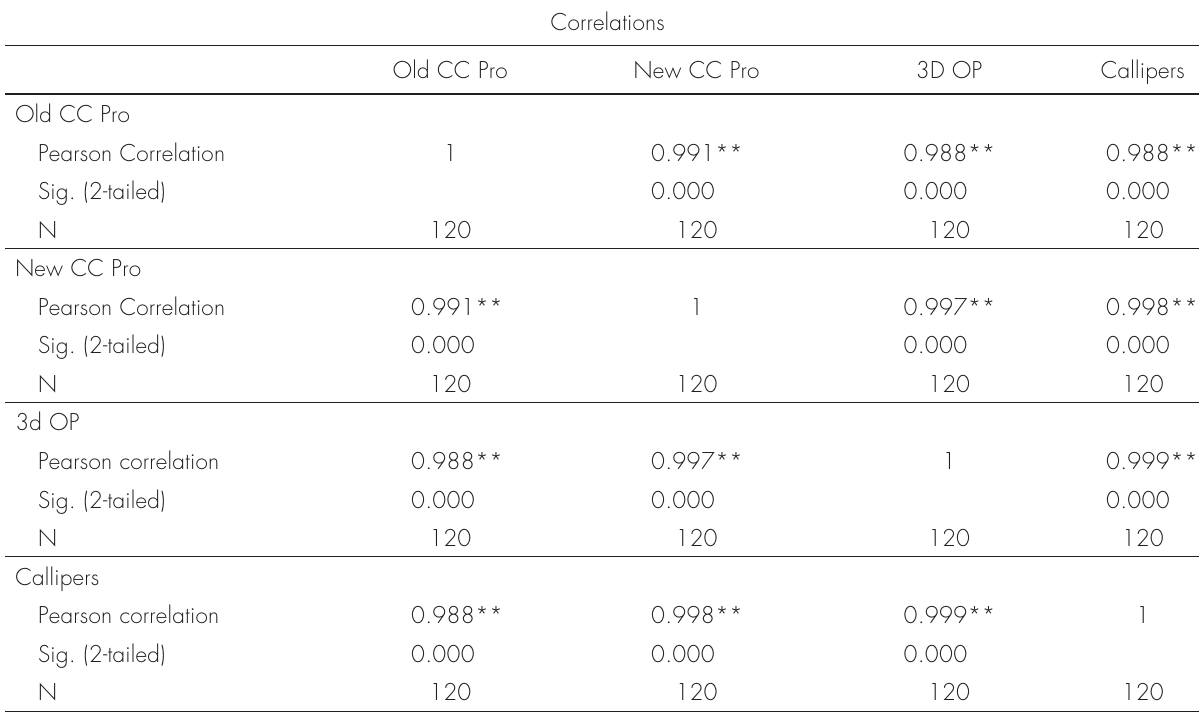
Table II. Correlation matrix ( n = 120) comparing both ClinCheck versions with ‘gold standard’